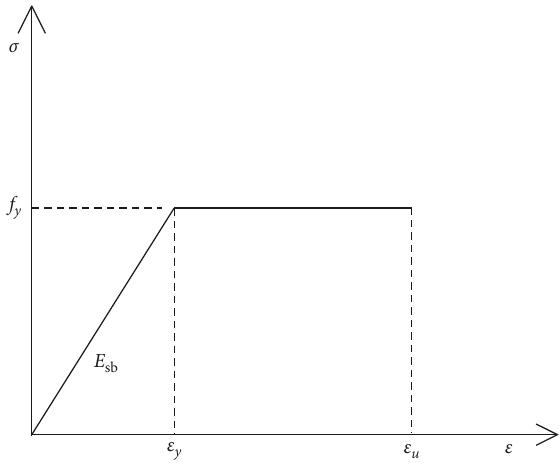
Figure 7: Stress-strain relationship of steel in the elastoplastic